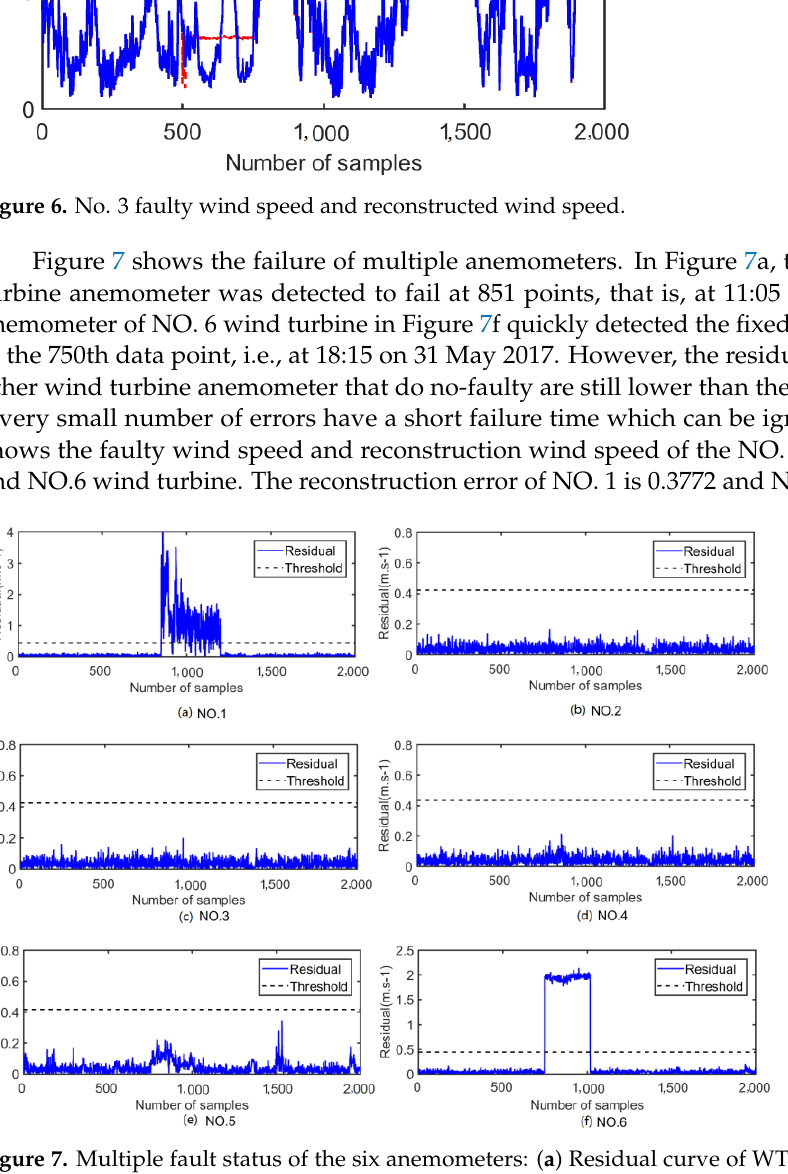
Figure 6. No. 3 faulty wind speed and reconstructed wind speed.